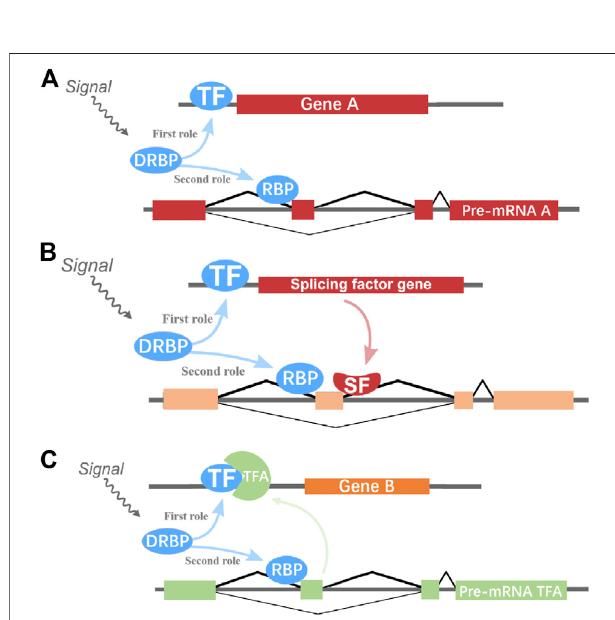
FIGURE4 | Hypothetical two-layer network regulatory models ofgenes. (A) DNA-andRNA-bindingproteinssplicingfactors(DRBP-SFs)mayregulate thesamegenesatthetranscriptionalandsplicinglevelastranscriptionfactors (TFs) and SFs, respectively. (B) OneDRBP-SFmay act asSF toregulate the splicing of one gene with another SF controlled by this DRBP-SF in the transcriptional regulation level. (C) One DRBP-SF may act as a TF to regulate the transcription of one gene with another TF controlled by this DRBP-SF in the splicing regulation.